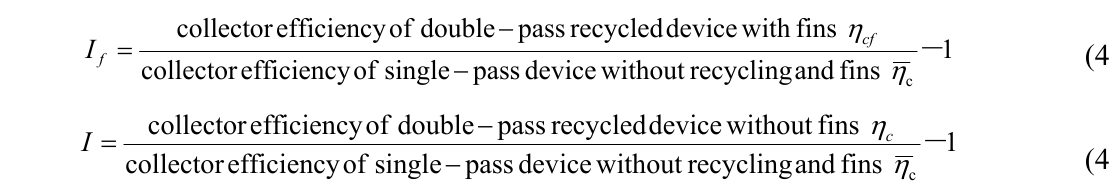
= 830 W/m 2 ; ( b ) I 0